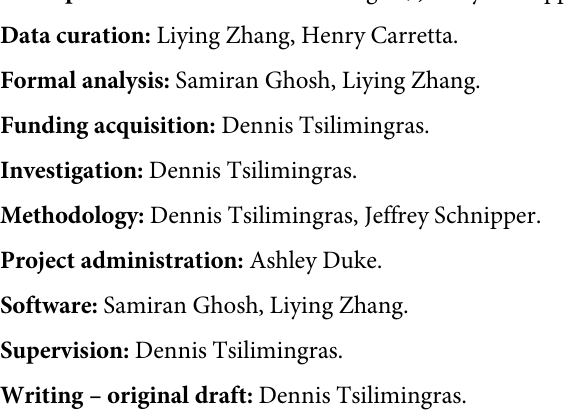
S1 Table. Telephone interview questionnaire. S2 Table. A comparison of patient characteristics for patients included in the study (N = 545) and patients excluded from the study (N = 168 and N =